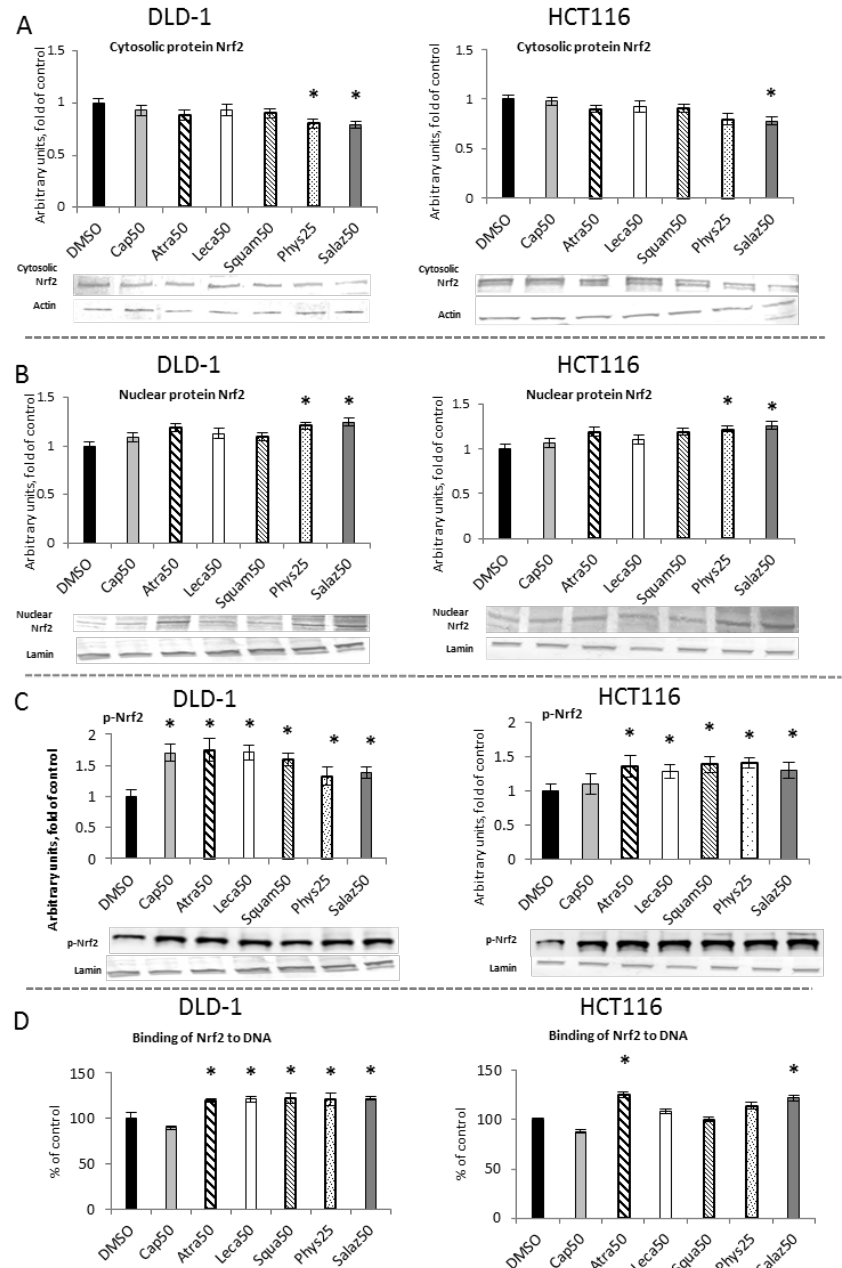
Figure 2. The effect of lichen-derived compounds on Nrf2 activation in DLD-1 and HCT116 cells. ( A ) The level of Nrf2 protein in the cytosolic fraction. ( B ) The level of Nrf2 protein in the nuclear fraction. ( C ) The level of p-Nrf2 protein in the nuclear fraction. Representative Western immunoblots are presented under the graphs ( A – C ). Results (means ± SEM from three separate experiments) are presented as a fold change to control after normalization against the level of actin or lamin. ( D )